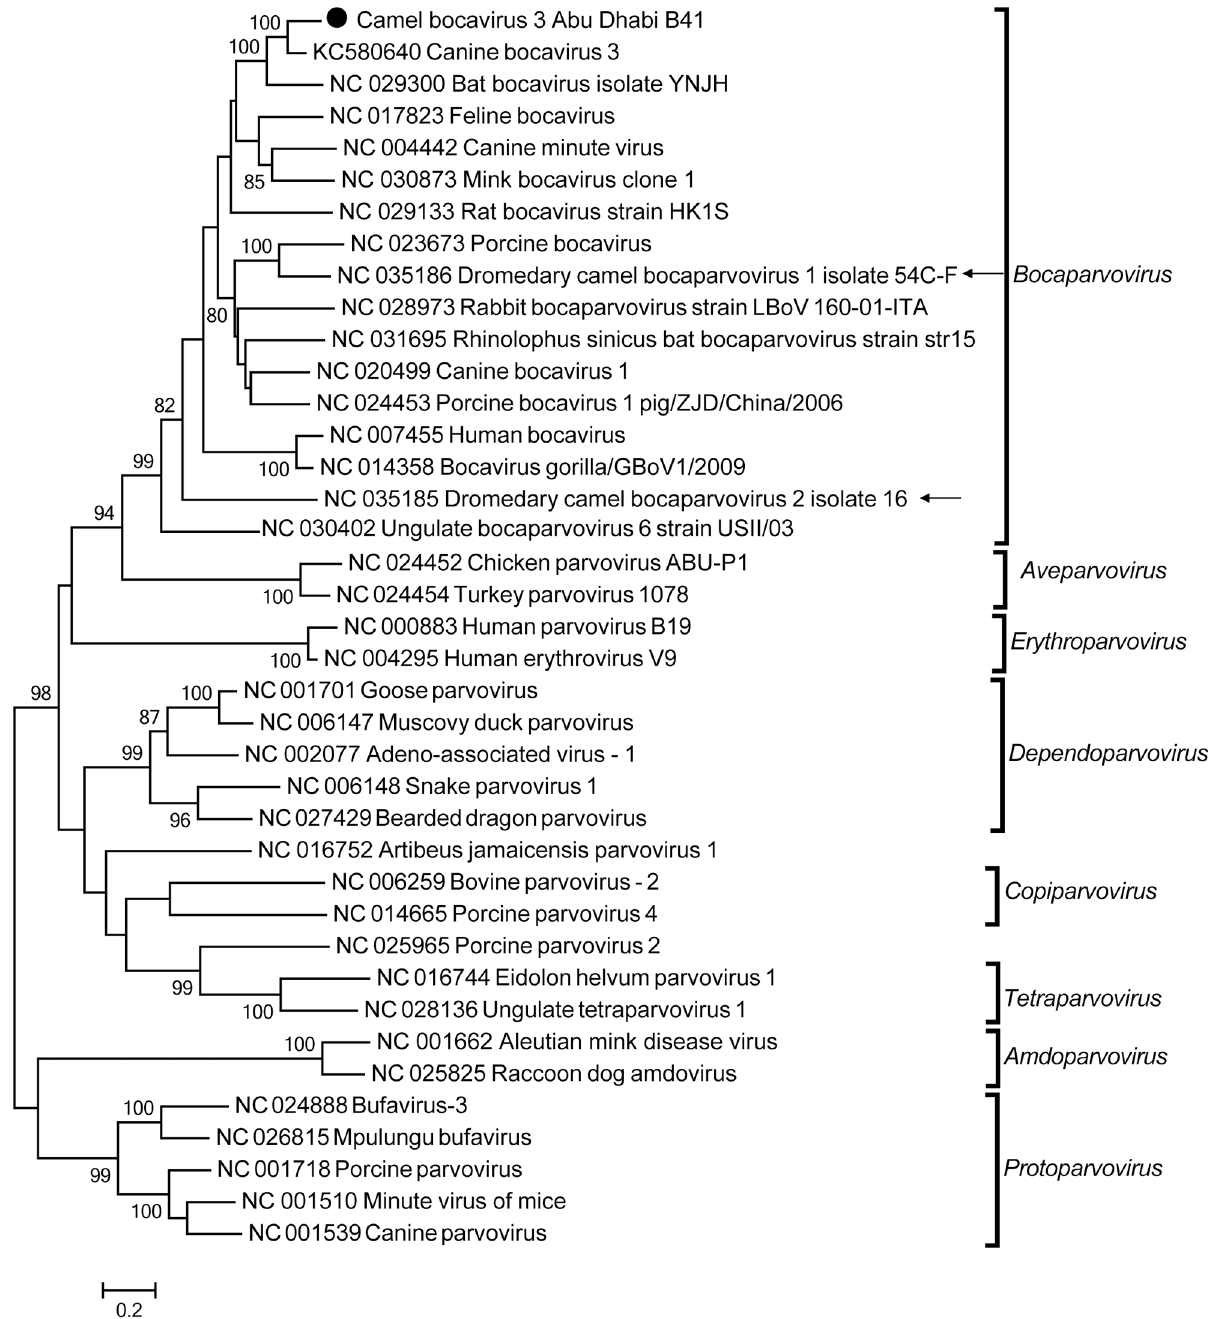
Fig 4. Phylogenetic analysis of camel bocavirus 3 Abu Dhabi. Maximum likelihoodphylogenetic tree was estimated basedon a 1905 nt- long contig sequencefrom one representative camel bocavirus3 Abu Dhabisequencedetected in this study and 38 previously published sequencesin Parvovirinae . The eight generain Parvovirinae are labeledaccordingly. The two known camel bocaparvoviruses are indicated by arrows. The camel bocaparvovirus identified in this study is highlightedby a solid circle. The scale bar indicates the estimated number of nt substitutionsper site and the bootstrapvalues ( (cid:21) 80) are